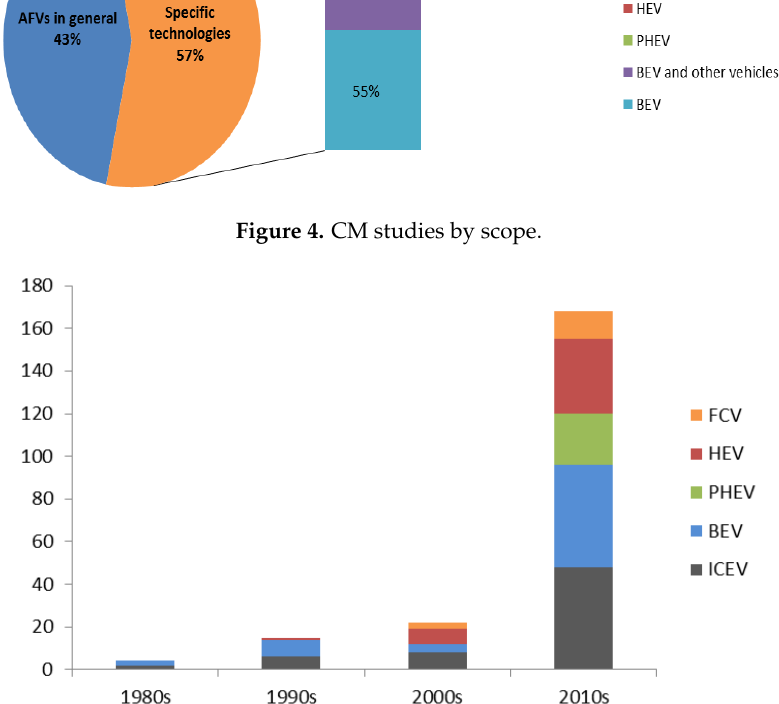
Figure 5. Vehicles included in the CM studies.